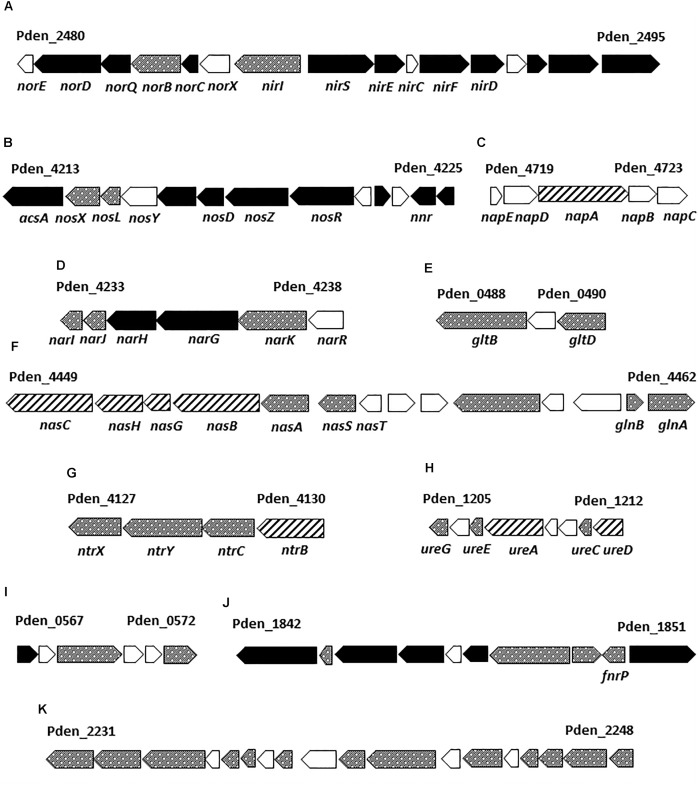
Paracoccus denitrificans PD1222 genes encoding several proteins detected by LC-MS/MS under denitrifying conditions. The reference codes correspond to the first and the last gene of each gene cluster according with UniProt (UP000000361). Gene-filling: black, genes encoding proteins found in abundance under anaerobic denitrifying conditions when compared to aerobic cultures; dotted, genes that code for proteins of unchanged levels in the presence or absence of oxygen; dashed, genes encoding proteins displaying low abundance under anaerobic conditions. Gene cluster descriptions are provided in Supplementary Figure S2.